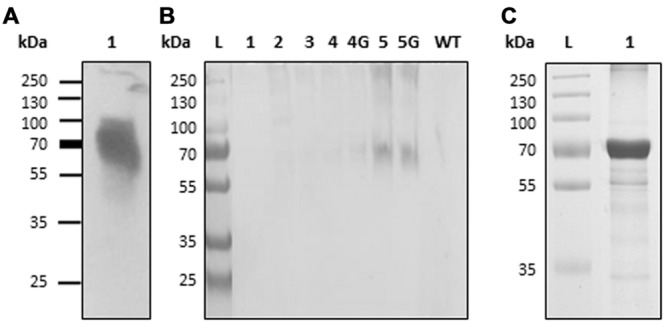
Production and isolation of H5-zein and H5. (A) Immunoblot analysis of a leaf extract containing H5-zein. (B) Immunoblot of H5-zein samples following the sucrose density gradient separation of leaf homogenates. Lanes 1–5: Selected samples from different density steps along the gradient are shown (lane 1: sample from the top of the gradient; lane 5: pellet. 4G and 5G are the same fractions as 4 and 5, but obtained from a different experiment). An antibody specific for the His6 tag was used for detection. (C) H5 after IMAC purification (3 μg were leaded on the gel and stained with Coomassie). wt, wild type; L, molecular weight ladder in kDa.